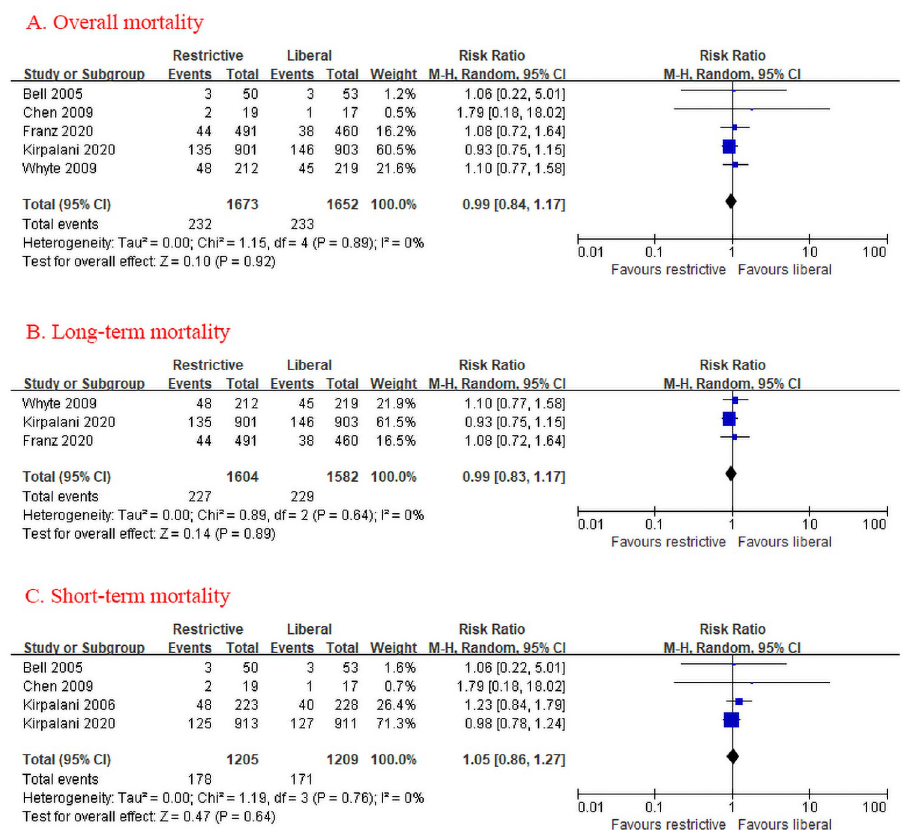
Fig 2. (A) Forest plot comparing overall mortality between restrictive and liberal RBC transfusion thresholds for VLBW infants. (B) Forest plot comparing long-term mortality between restrictive and liberal RBC transfusion thresholds. (C) Forest plot comparing short-term mortality between restrictive and liberal RBC transfusion thresholds. RBC: Red blood cell; VLBW: Very low birth weight.